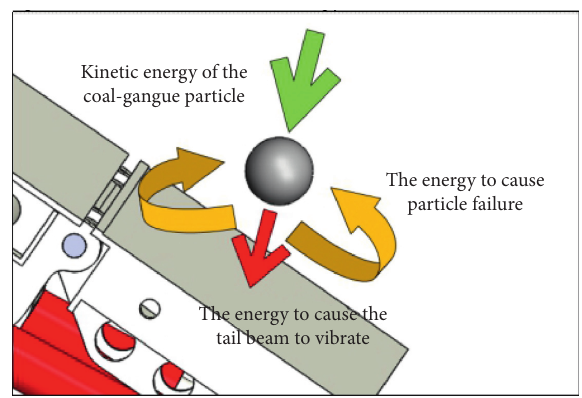
Figure 2: Energy change of coal gangue particle impacting the tail